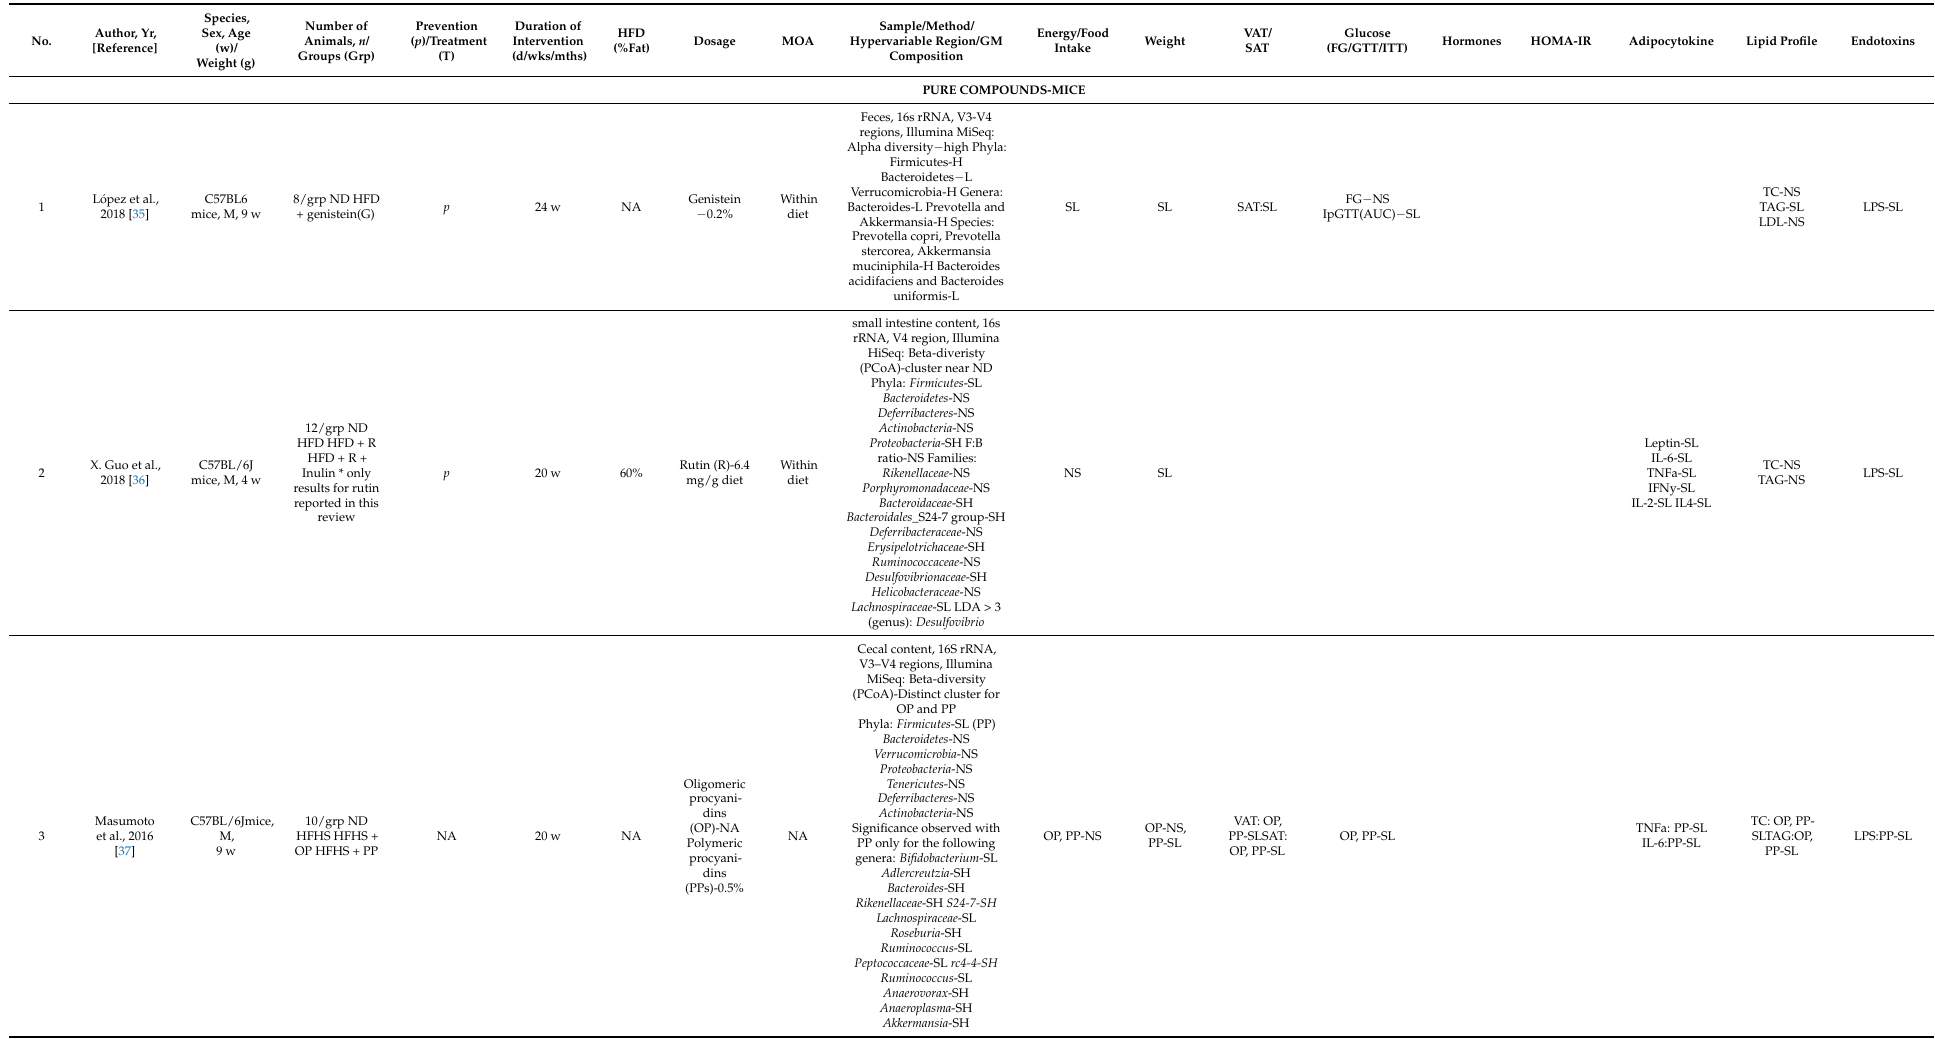
Table 2. Characteristics of reviewed animal